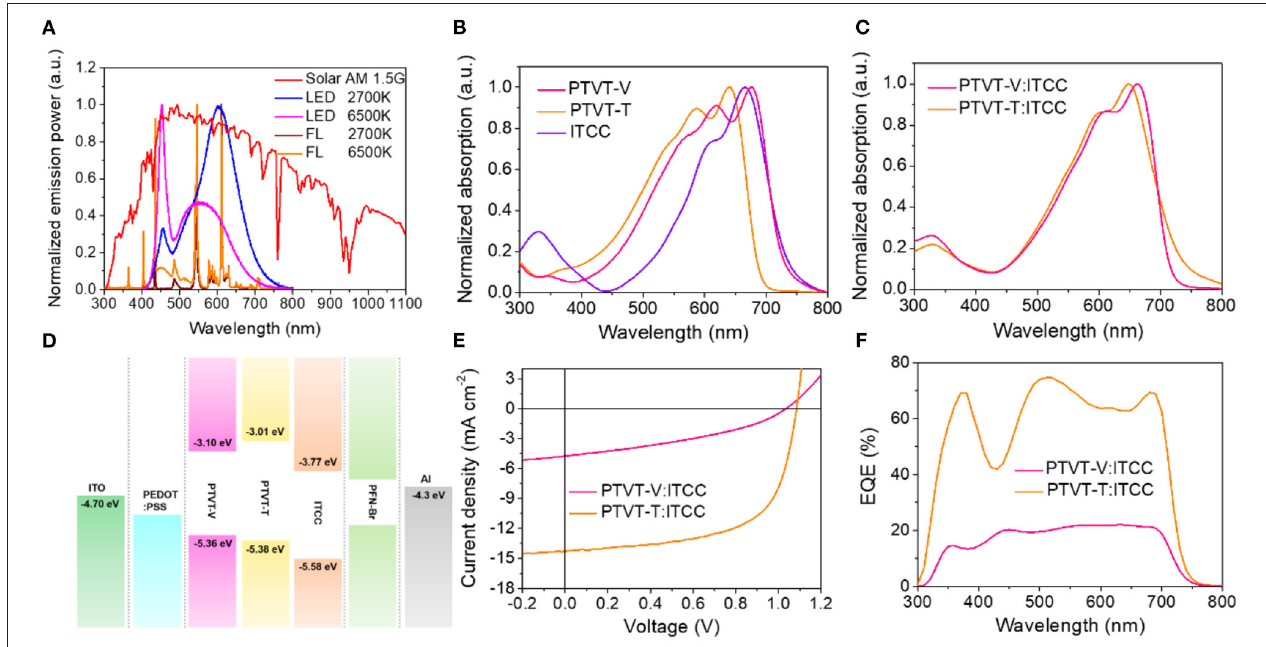
FIGURE 2 | (A) The spectra of AM 1.5G and various indoor light sources. (B) The absorption spectra of neat films of PTVT-V, PTVT-V, and ITCC. (C) The absorption spectra of blend films of PTVT-V:ITCC and PTVT-T:ITCC. (D) Energy level diagrams of the materials used in this work. (E) J-V curves of the OPV devices based on PTVT-V:ITCC and PTVT-T:ITCC under the illumination of AM 1.5G, 100 mW cm − 2 . (F) The corresponding EQE spectra of the devices.